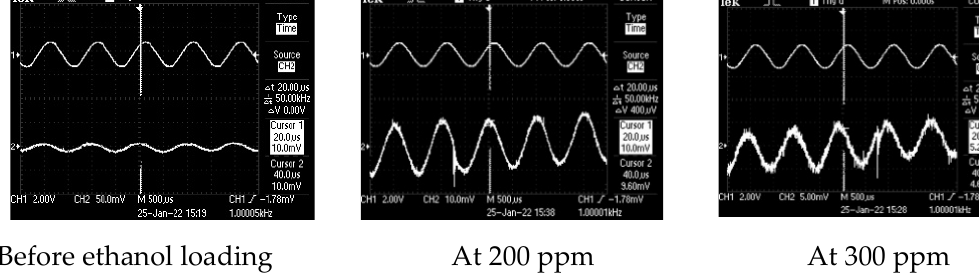
Table 1. Main ethanol detection parameters of SAW devices with different IDT patterns and using carbyne-enriched coating as a sensing material.